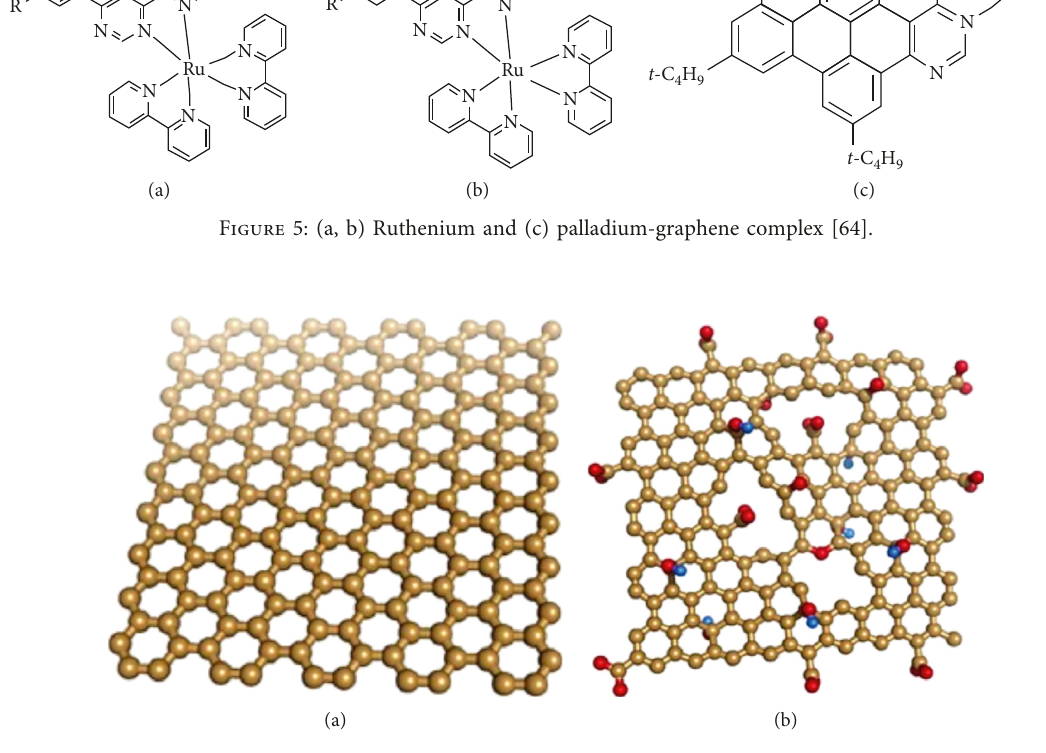
Figure 6: Schematic structure of graphene (a) and graphene oxide (b)